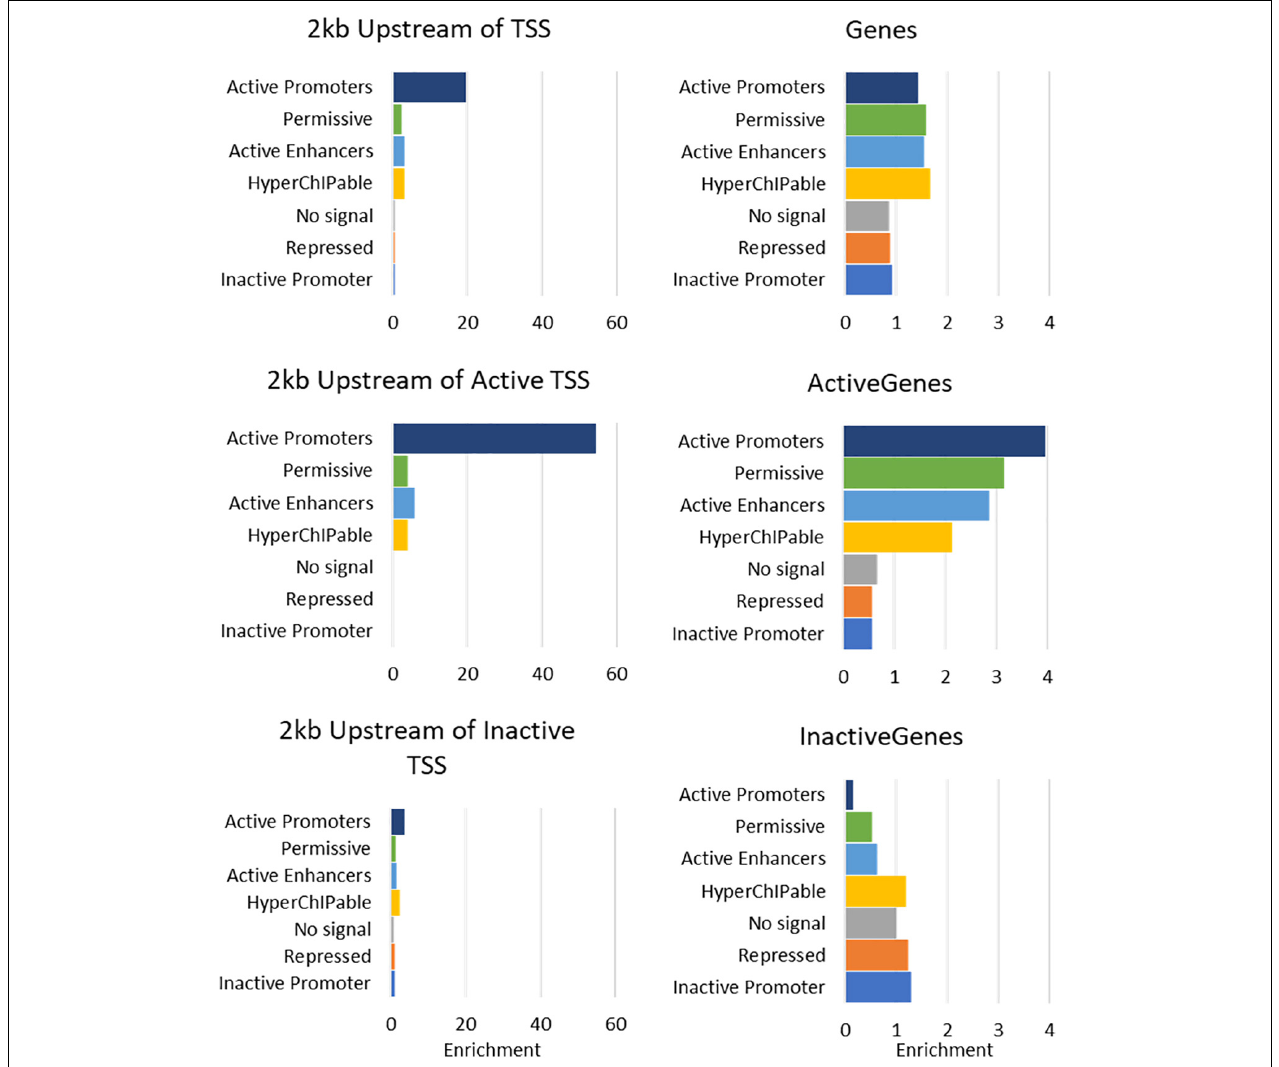
FIGURE 4 | Enrichment of 7 Chromatin states in Mammary Gland at annotated regions of the bovine genome. For more details of enrichment at annotated regions see Supplementary Figure 5